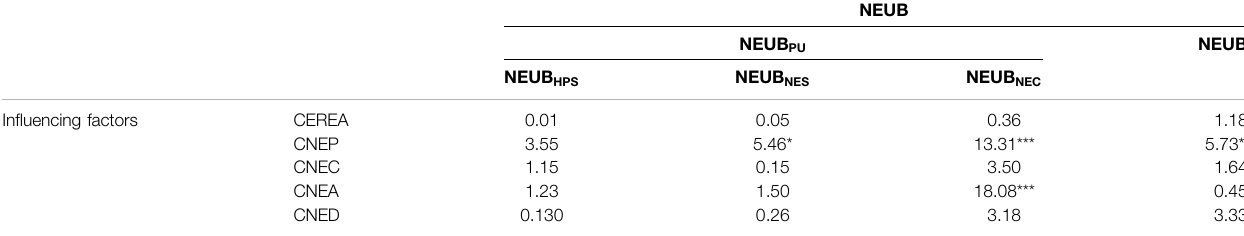
TABLE 2 | ANOVA analysis of NEUB on CEREA, CNEP, CNEC, CNEC, and CNED.